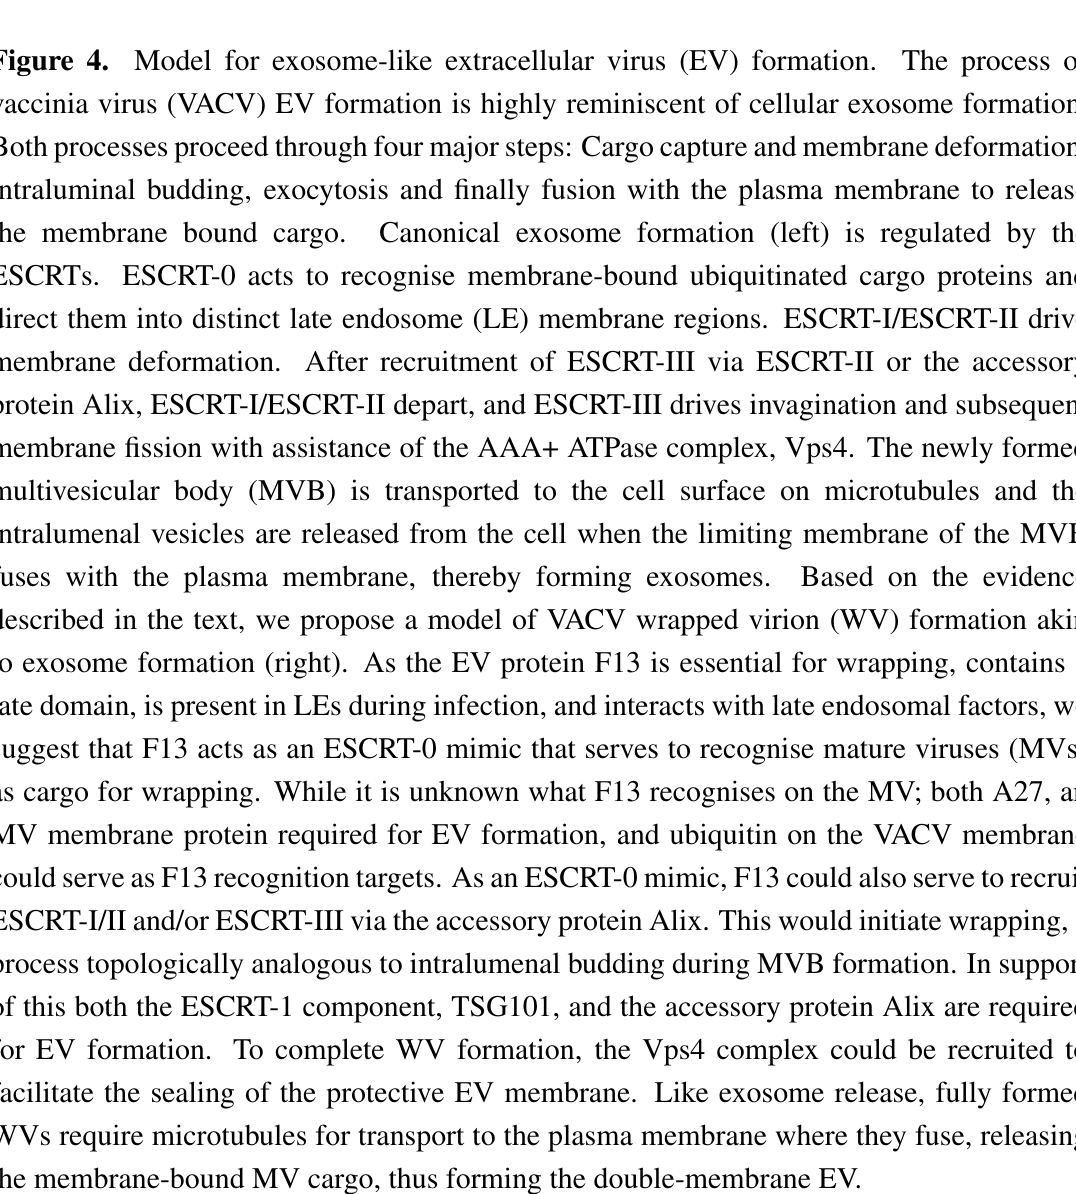
Figure 4. Model for exosome-like extracellular virus (EV) formation. The process of vaccinia virus (VACV) EV formation is highly reminiscent of cellular exosome